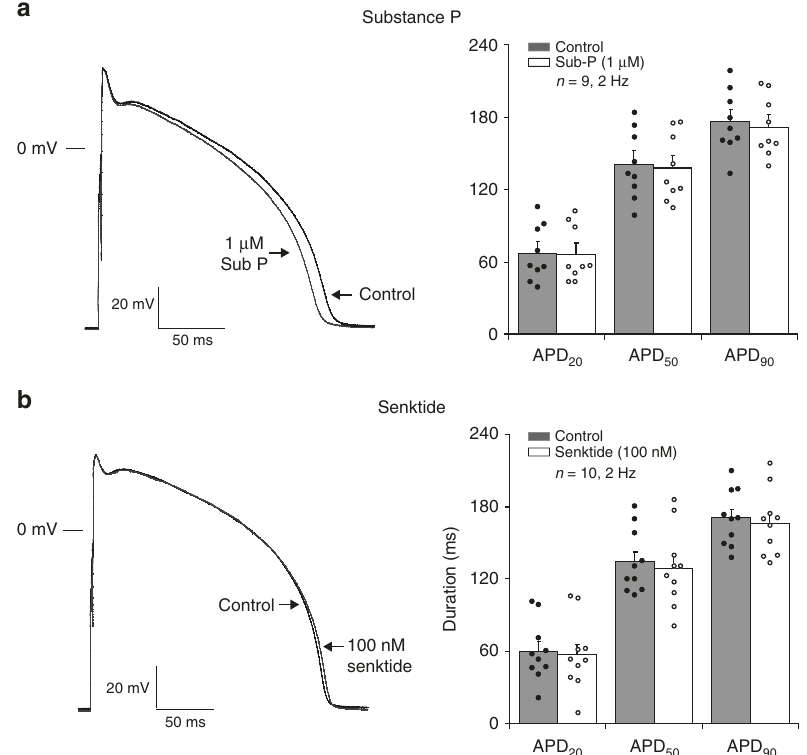
Fig. 7 Effect of NK-3 receptor stimulation on action potentials of ventricular myocytes. ( a – b , left panel) Ventricular APs elicited at 2 Hz under control conditions (Control) and in the presence of 1 µ M Sub-P a or 100 nM Senktide b . ( a – b , right panel) Bar graph showing average values for AP duration at 20, 50 and 90% of repolarization (APD 20 , APD 50 and APD 90 ) before (Control) and after application of 1 µ M Sub-P ( a , N = 5, n = 9) or 100 nM Senktide ( b , N = 5, n = 10). Paired t -test. All values shown are mean ± SEM. * P <